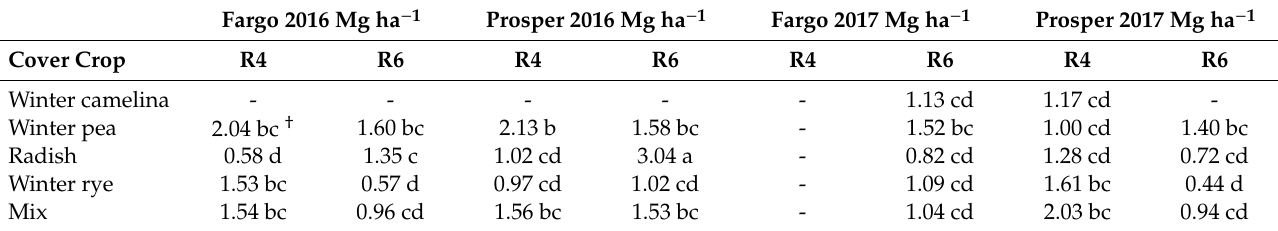
Table 4. Mean fall cover crop biomass yield in Fargo and Prosper, ND, in 2016 and